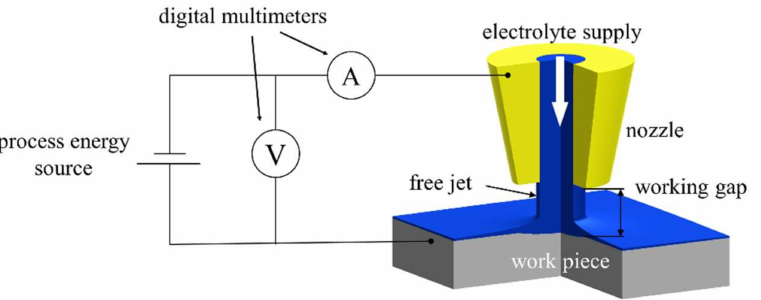
Figure 4. Schematic of the experimental setup for jet-based anodization, modified according to